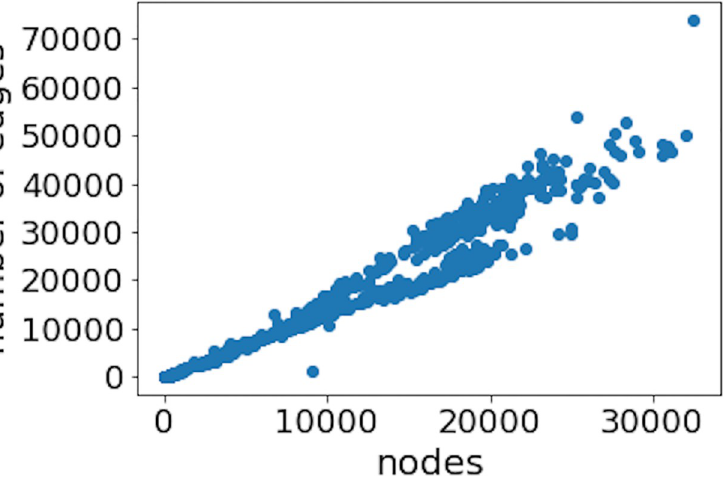
Fig 7. Relation between the number of nodes and links for daily data. It can be seen that the growth of links in the bitcoin network is approximately linear.